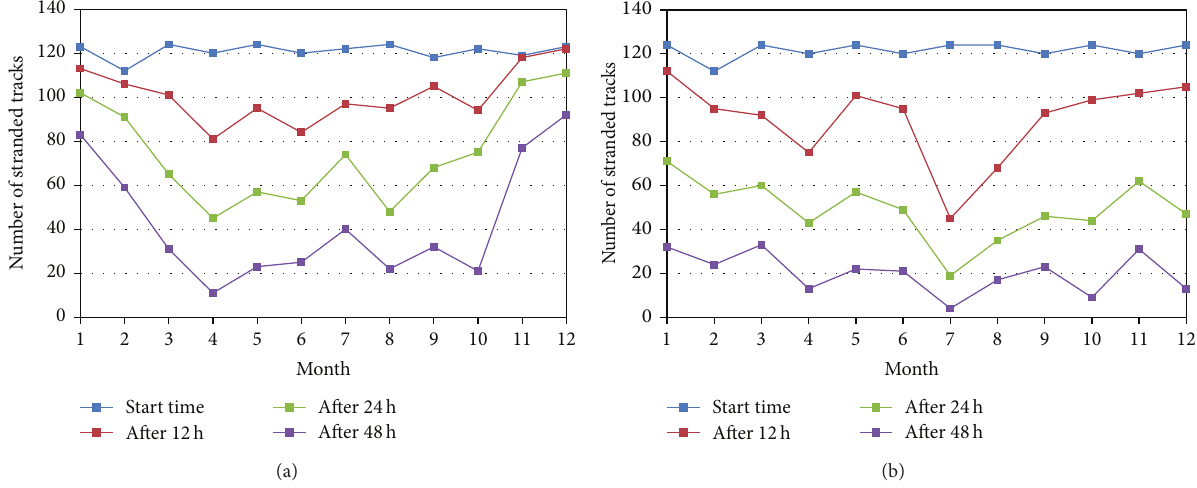
Figure 8: The number of trajectories that still stay inside the study area of (a) the Sichuan Basin and (b) the circle region centering on Yueyang with 2.5 ∘ radius after 4 different transport times (0, 12, 24, and 48